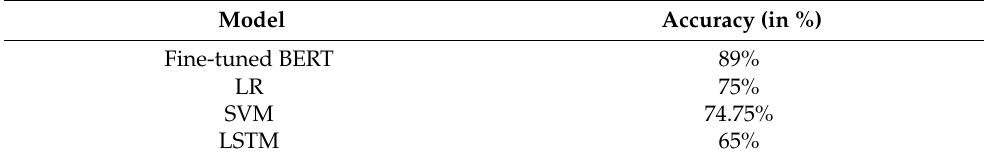
Table 3. Accuracy comparisons of four models.